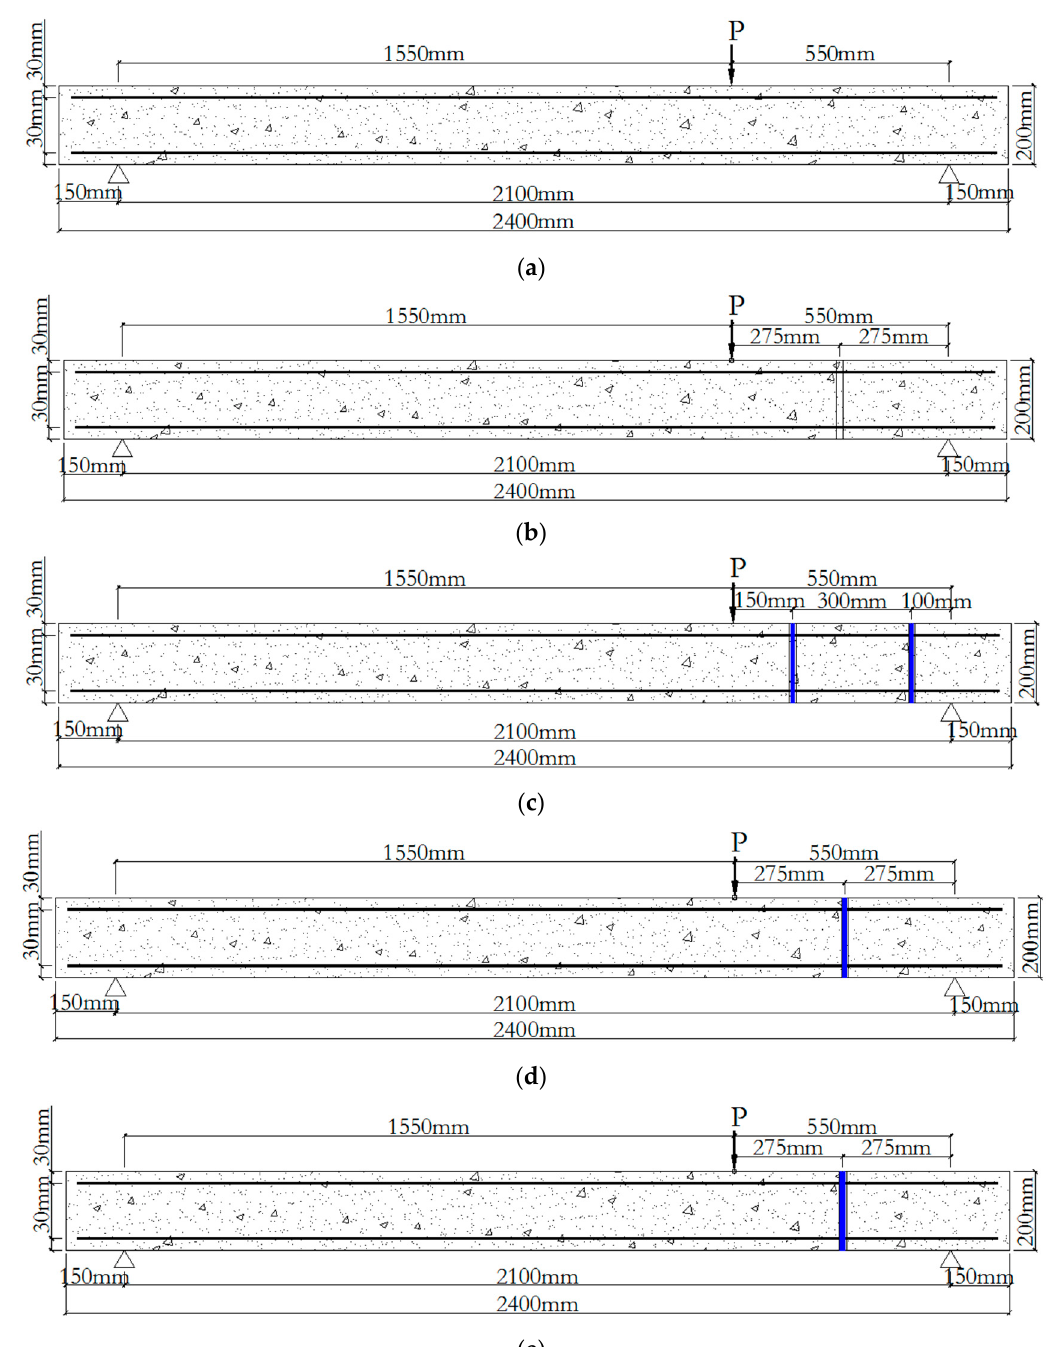
Figure 2. Details of test specimens in elevation: ( a ) Specimen coded as S-Con; ( b ) Specimen coded as S-D-1; ( c ) Specimen coded as S-S-2-10, S-B-2-9, S-G-2-9, S-C-2-9; ( d ) Specimen coded as S-C-1-9; and ( e ) Specimen coded as S-C-1-13.